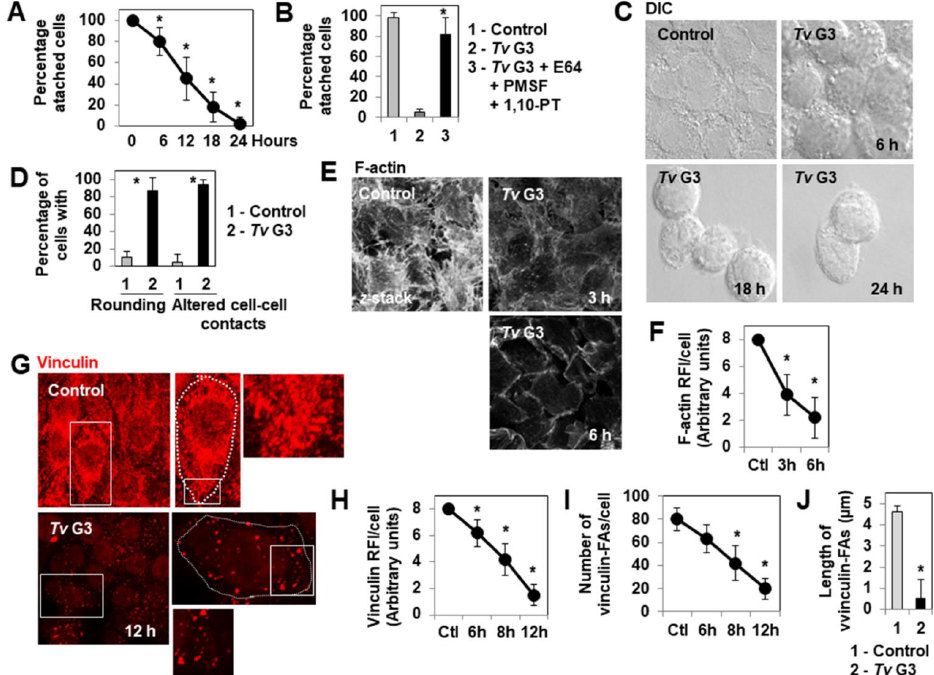
Figure 1. The F-actin network, cell-to-cell contacts, and focal adhesion contacts are altered in a time-dependent manner by Tv G3, leading to the detachment of cervicovaginal HeLa epithelial cells. In ( A ), progression of Tv G3-induced cell detachment over a time course. In ( B ), Tv G3-induced cell detachment with and without a combination of protease inhibitors (the E64 cys- teine protease inhibitor at 100 µM, the PMSF serine protease inhibitor at 2 mM, and the 1,10-PT metalloprotease inhibitor at 5 mM) (24 h post-infection (pi)). In ( C ), representative differential in- terference contrast (DIC) micrographs of cells showing a rounding of the cell surface and altera- tions to cell-to-cell contacts. In ( D ), percentages of cells displaying rounding and alterations to cell-to-cell contacts (6 h pi). In ( E ), representative confocal laser scanning microscopy (CLSM) im- ages of the F-actin network. In ( F ), decrease in F-actin relative fluorescence intensity (RFI)/cell over time. In ( G ), representative CLSM images of vinculin-positive focal adhesions (FAs). In ( H ), de- crease in vinculin RFI/cell over a time course. In ( I ), decrease in the number of vinculin-positive FAs/cell over time. In ( J ), length of vinculin-positive FAs (6 hpi). The micrographs shown are rep- resentative of two independent experiments. In F, the white box indicates the cell viewed at high magnification in the adjacent image. The dashed white line delineates the area occupied by the cell cytoplasm. Ctl: Control. Each value shown is the mean ± SD of at least two independent experi- ments. In ( A ), * p < 0.01 for comparisons with T 0 . In ( B ), * p < 0.01 for comparisons with Tv G3. In ( D , F , H – J ), * p < 0.01 in comparisons with Control. 2.2. Pre-Adherent L. gasseri Bacterial Cells Delay Tv G3-Induced Cell Detachment Phunkan et al. [44] demonstrated that the adhesion of T. vaginalis F1623, G3 and BR7C2 parasites to hVECs is strongly inhibited if these cells are already colonized by L. gasseri ATCC 9857 bacteria. We investigated whether the adhesion of Tv G3 trophozoites to confluent HeLa cell monolayers was inhibited by the precolonization of the cells with L. gasseri KS 120.1. We used L. gasseri ATCC 9857 cells as a positive control. Similar,